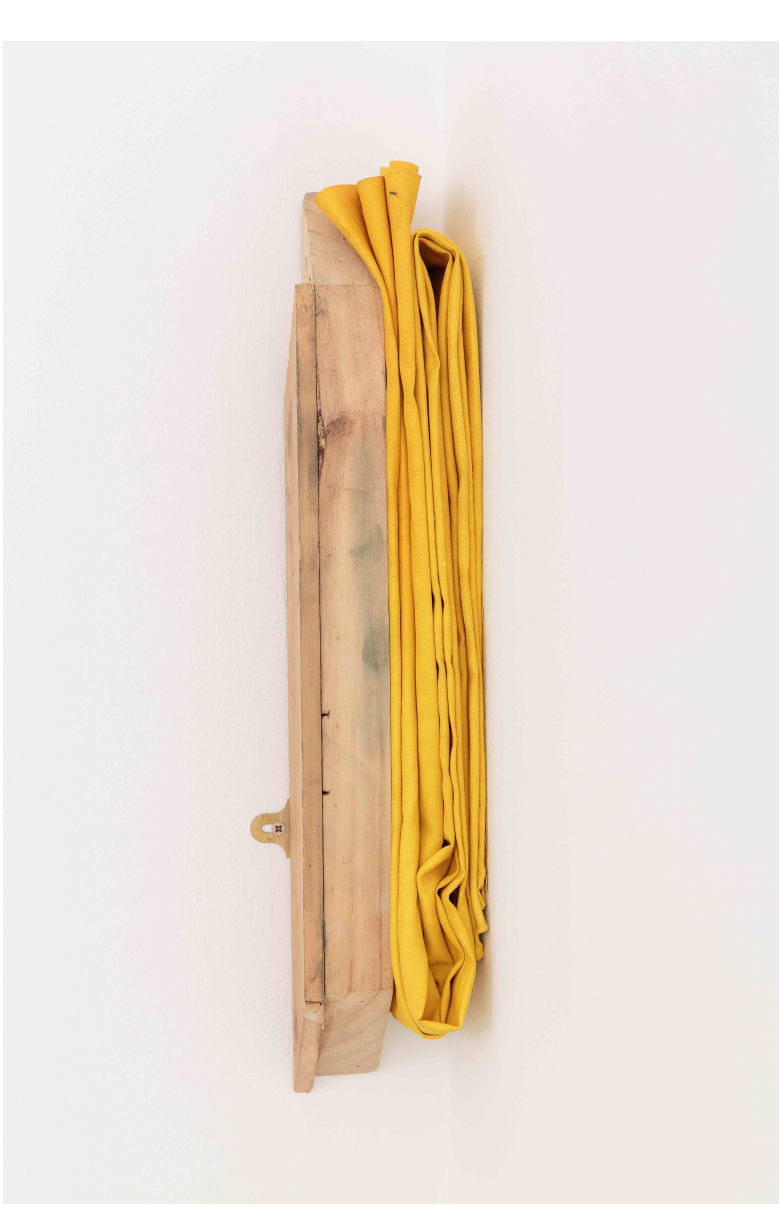
Figure 9: Jo McGonigal, Lean (Yellow) , 2016, wood, lycra, pigment. 58 x